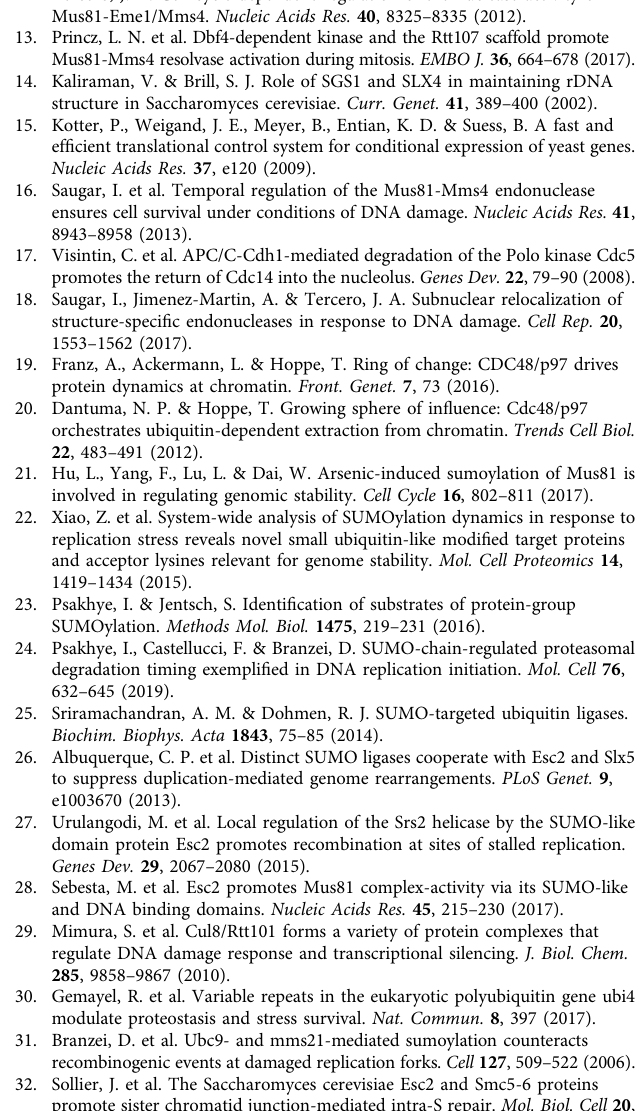
Fig. 7 Mms4-Mus81 mutant with associated Mms4-P stabilization delays DNA damage response and causes fragility of replication intermediates. a Time course experiment analyzing Mms4 species within one cell cycle in WT and mms4 Δ 541-555 mus81 Δ 121-135 . Logarithmically (log) grown cells expressing Mms4 and Mus81 variants from Tc-ADH1-HA promoters were synchronized in G1 phase with α -factor ( α F) and then released in YPD medium in the presence of 1 mM Tetracycline ( + Tet). After cells reached G2/M, α -factor was again added to the culture. Samples were taken at the indicated timepoints and the presence of HA-tagged Mms4 species and of Cdc5 was analyzed by western blot. Pgk1 served as loading control. The percentage of phosphorylated Mms4 versus total Mms4 was quanti fi ed. Cell cycle progression of the cells during the experiment was followed by fl ow cytometric analysis. 1N and 2N in gray indicate G1 and G2/M phases, respectively. b Kinetics of Rad53 phosphorylation in WT and the mms4 Δ 541-555 mus81 Δ 121-135 truncation mutant (see a ). Cells were synchronized in G1 phase and then released in YPD medium containing 0.033% MMS. Samples were taken at the indicated timepoints and analyzed by western blot for Rad53 and for Tubulin, which served as loading control. Three independent experiments ( n = 3) were used for the quanti fi cation of Rad53 phosphorylation; the bars represent the mean values ± SEM. P values were obtained by using a two-tailed unpaired Student ’ s t test with Welch ’ s correction, the asterisks indicate * P < 0.05 and ** P < 0.01. P value for 30 min = 0.0018, 45 min = 0.0417. NS stands for not signi fi cant. c 2D gel pro fi les of recombination intermediates isolated from cells of the indicated genotype. SGS1-AID and mms4, mus81 alleles are expressed from Tc-ADH1 - HA promoters, not indicated. Cells were synchronized in G1 phase with α -factor and then released in medium containing 0.033% MMS. Auxin was added during G1 arrest and after release to induce Sgs1-AID depletion, monitored by western blot. Pgk1 served as loading control. Cell cycle progression of the cells during the experiment was followed by fl ow cytometric analysis. Replication intermediates were digested with Nco I and visualized using a radioactively labeled probe speci fi c for ARS305 in 2D gel electrophoresis. Signal intensities were quanti fi ed, normalized to the monomer spot, and shown relative to the highest value. Red arrows indicate X-shaped replication intermediates. Source data are provided as a Source data